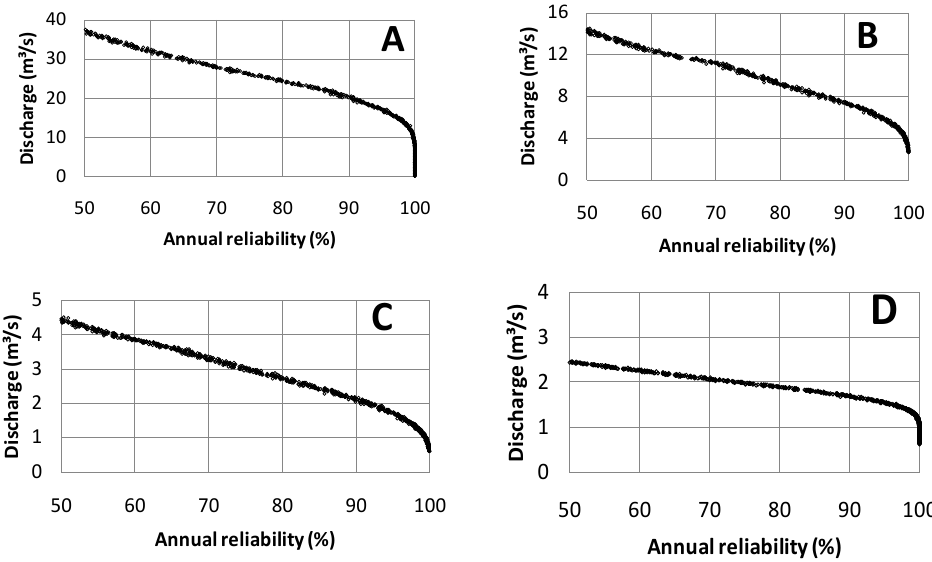
Figure 3. Withdrawal discharge as a function of the annual reliability level for the focus reservoirs: ( A ) Orós; ( B ) Araras; ( C ) Pentecoste; and ( D ) Aracoiaba.